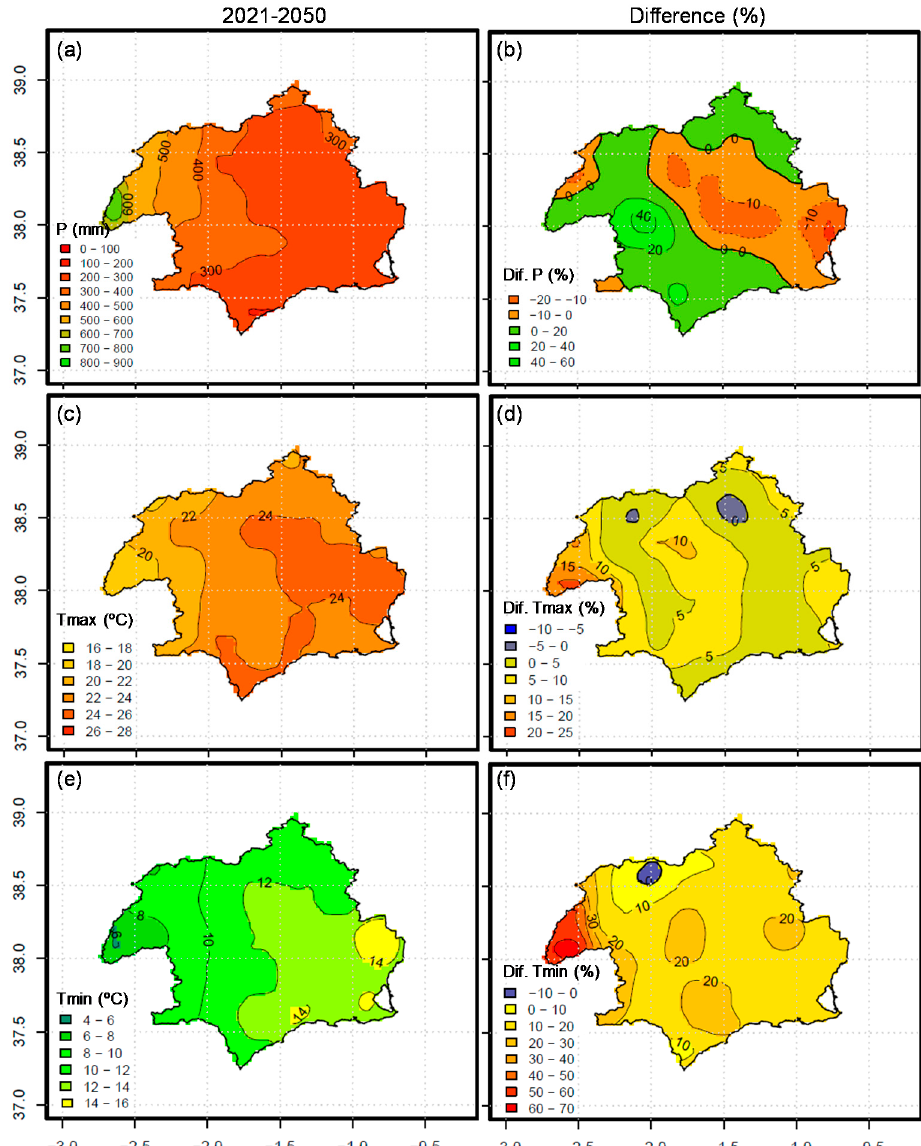
Figure 8. Spatial distributions of mean annual RCM ensembles for 2021–2050 and difference (%): ( a , c , e ) RCM ensemble of mean annual rainfall ( P ), maximum temperature ( T max ) and minimum temperature ( T min ) for 2021–2050; and ( b , d , f ) Difference (%) maps between 2021–2050 with respect to the 1961–1990 observational dataset, assessed as [100 × (mapEns − mapObs)/mapObs].